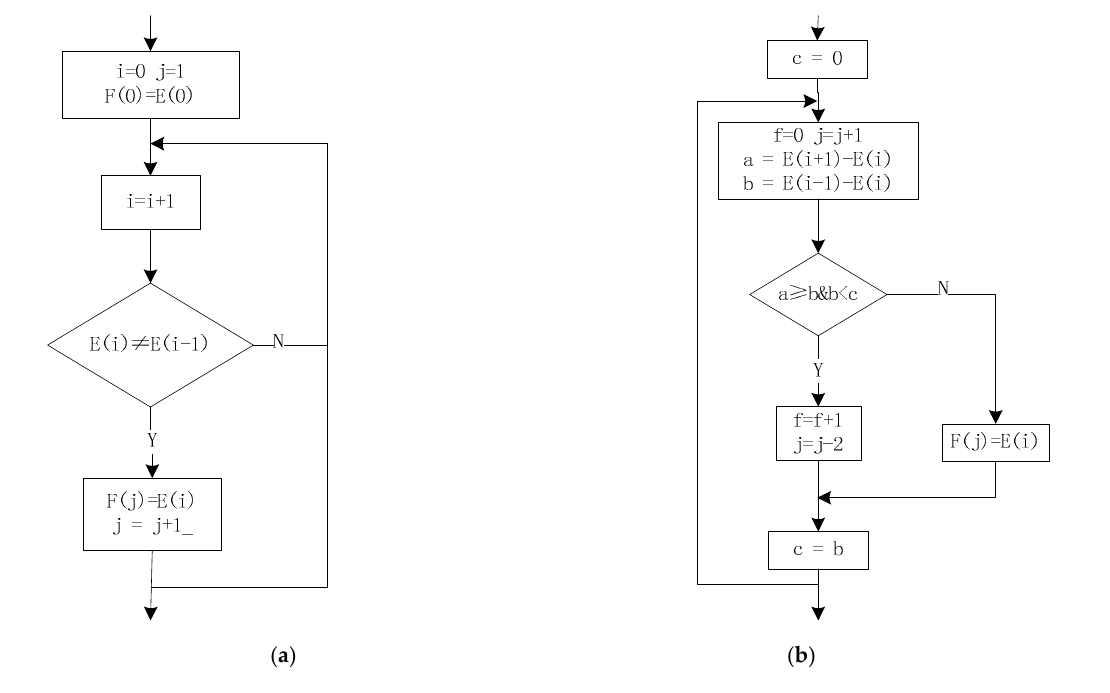
Figure 8. ( a ) Compression equivalent point, ( b ) Extract cycle diagram.